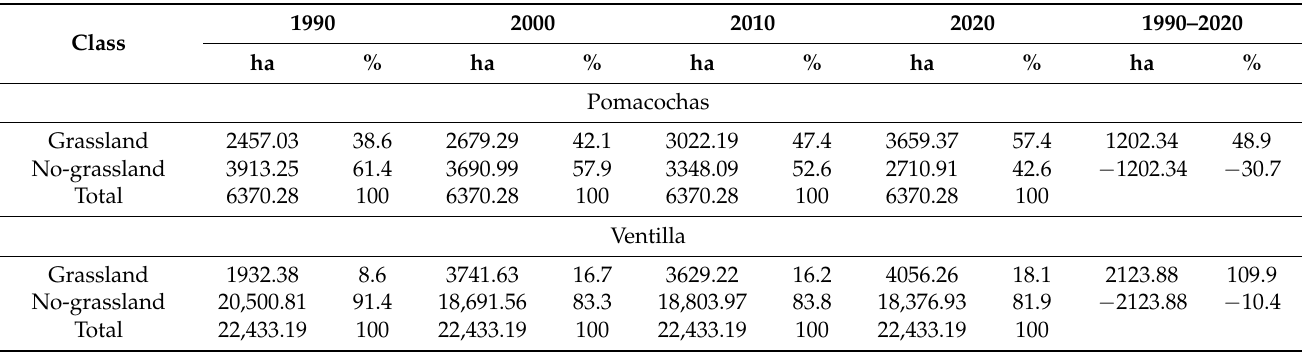
Table 3. Area (in ha) of grassland and no-grassland in 1990, 2000, 2010 and 2020 in the micro- watersheds of Pomacochas and